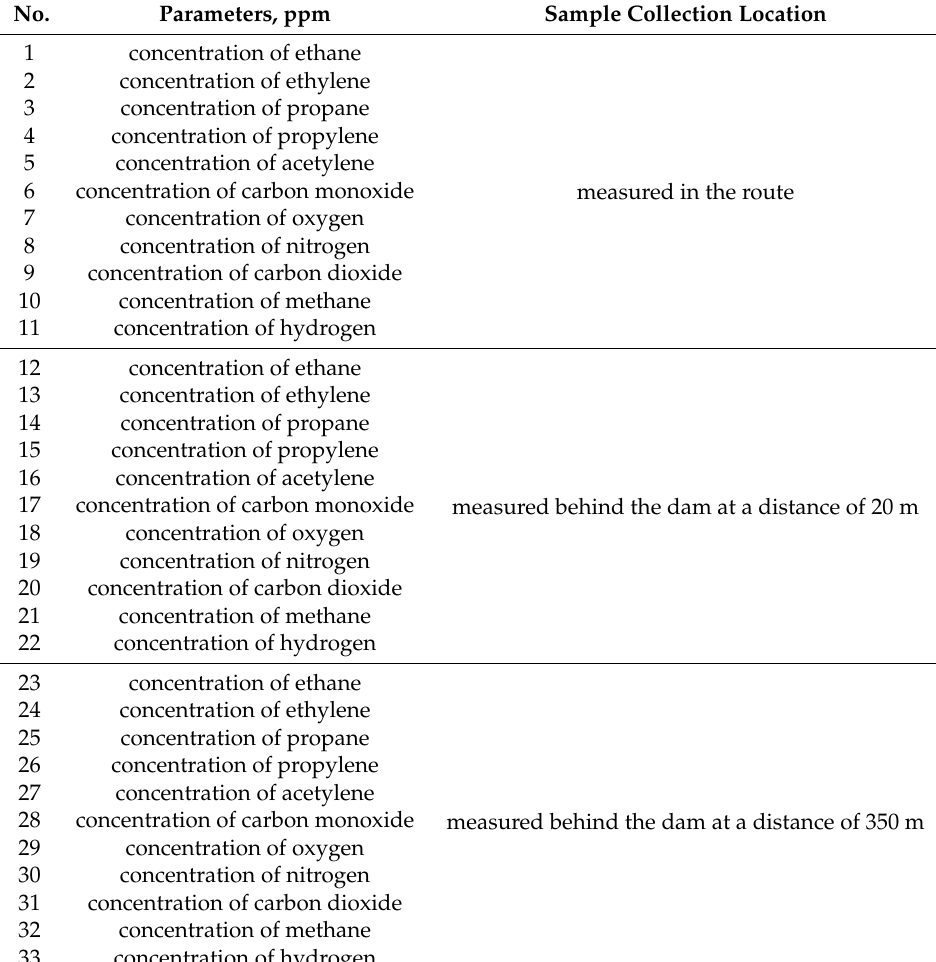
Table 1. The measured